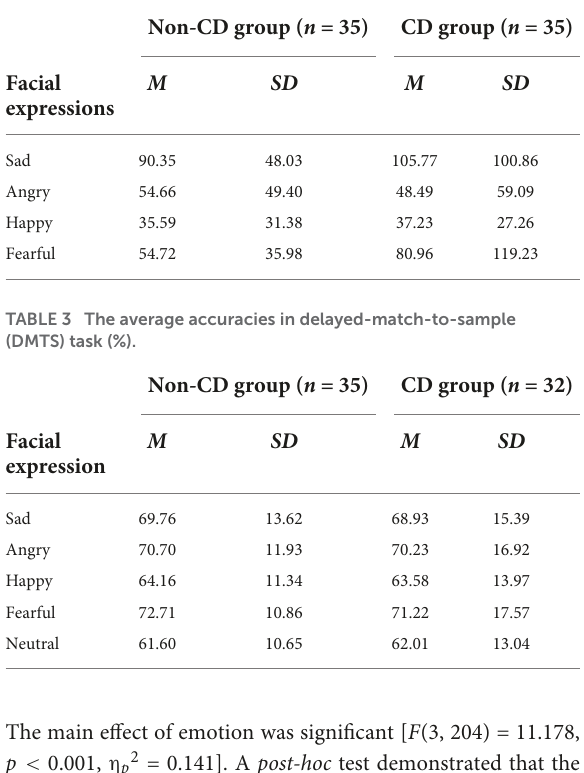
TABLE 2 The average search slopes in the visual search task.